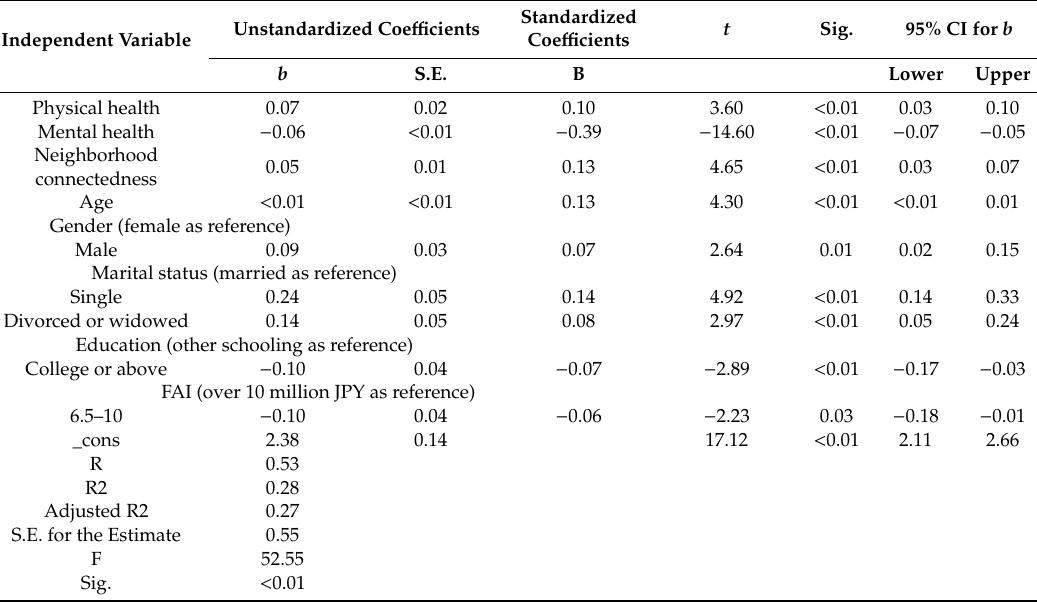
Table 2. Linear regression results in happiness and independent variables (N =